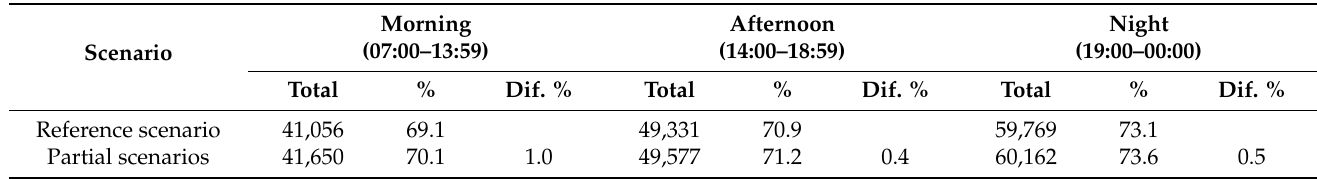
Figure 9. Partial scenarios: Optimal location of parking spaces with dynamic models adapted to demand in each of the time bands. ( a ) Morning. ( b ) Afternoon. ( c ) Night. Table 5. Demand covered by parking spaces in each of the time bands.